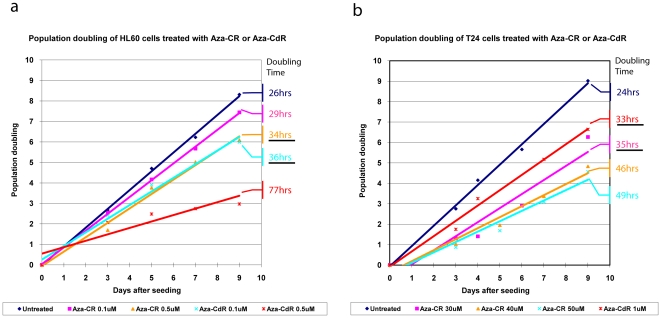
Estimation of population doubling times in the HL-60 and the T24 cell lines.Population doubling (PD) curves of the HL-60 (a) and (b) T24 cell line. Levels of cellular growth after treatment, with the indicated drug regimens plotted as population doublings against time. Initial drug treatment was started 24 h after seeding. The lines are trend lines.